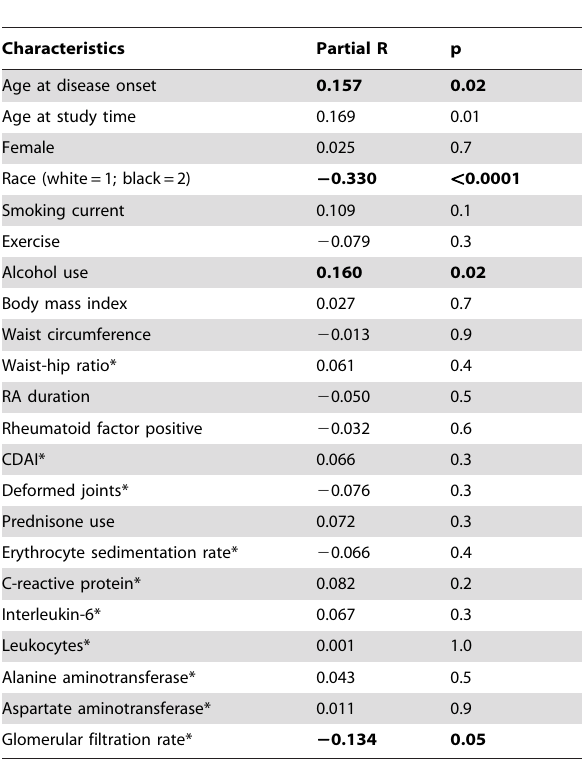
Table 2. Associations of baseline characteristics with retinol binding protein 4